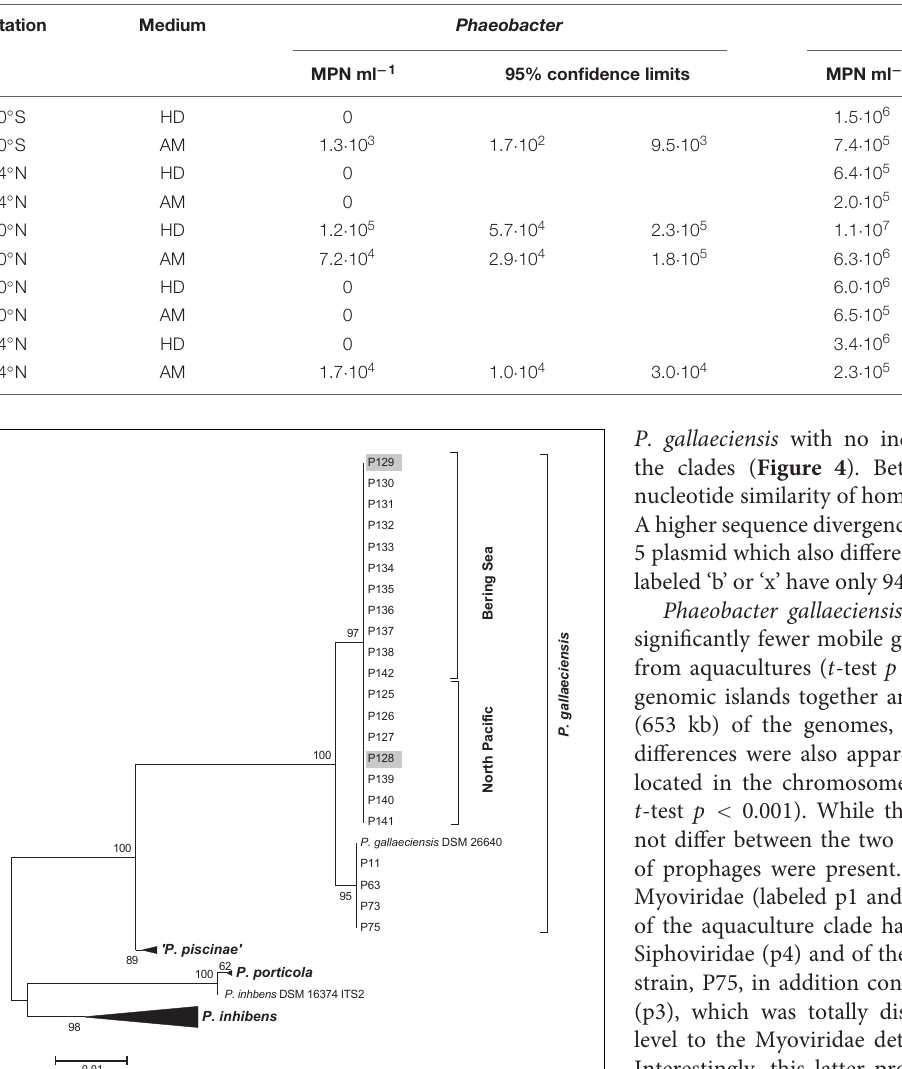
genes which are located on a small, 15-kb plasmid present in P129 but not P128 (labeled f in Figure 3 ). This plasmid carried a replication system and also a restriction system.